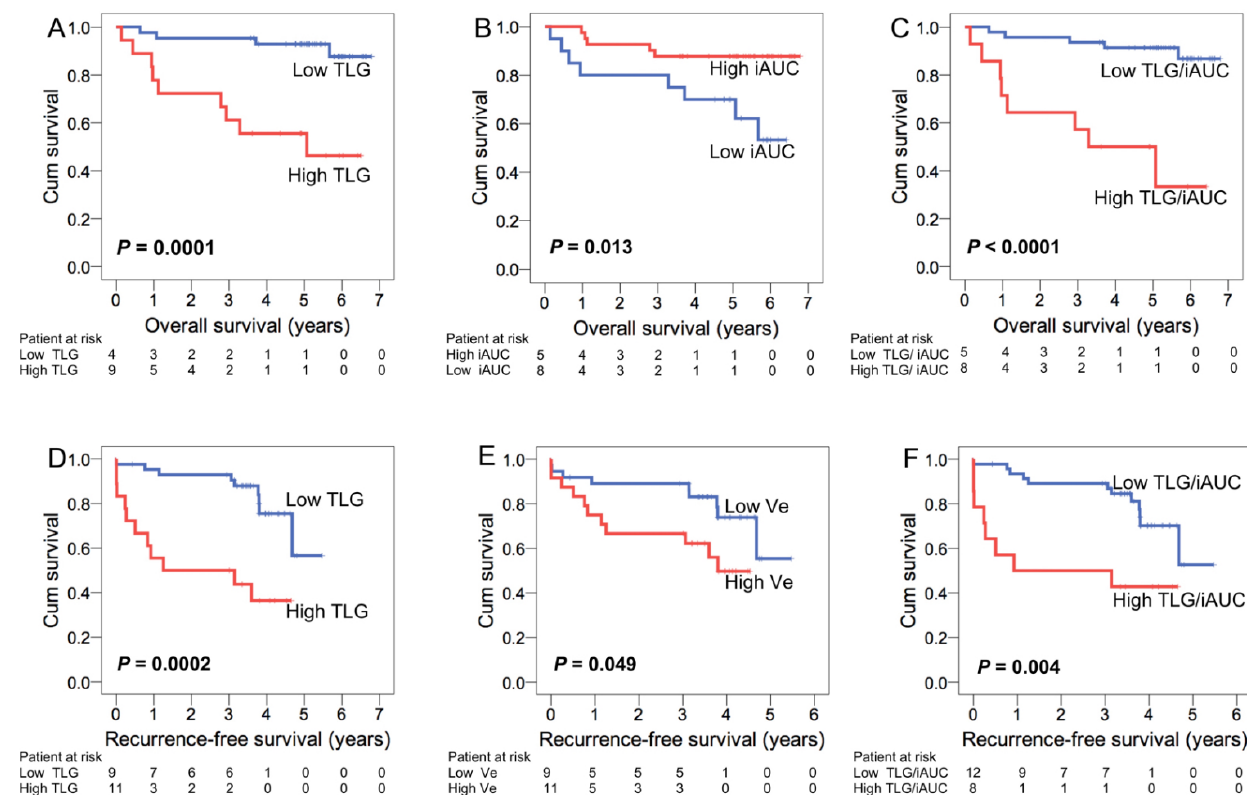
Figure 1. Kaplan-Meier plots of advanced nasopharyngeal carcinoma (NPC) patients stratified based on high and low levels of the independent imaging biomarkers. TLG ( A ), iAUC ( B ), and TLG/iAUC ( C ) were identified as significant predictors of overall survival. TLG ( D ), Ve ( E ), and TLG/iAUC ( F ) were as significant factors for the analysis of recurrence-free survival.